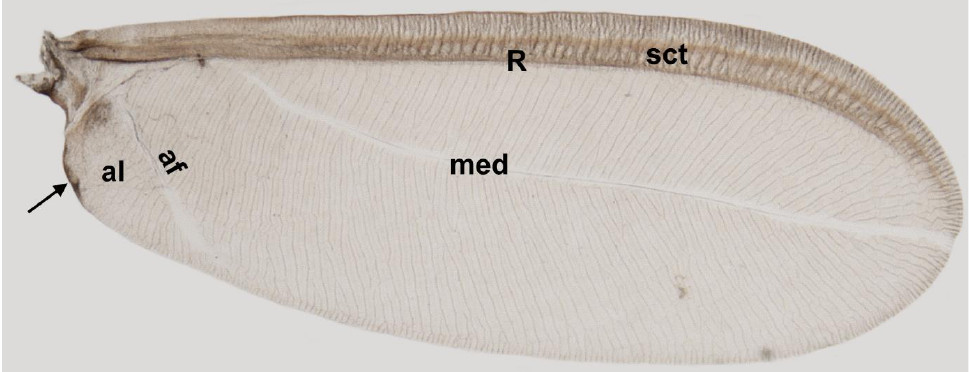
Figure 1. Forewing of Matsucoccus pini under LM. R—Radius, sct—subcostal thickening, med—median fold, al—anal lobe, af—anal fold; black arrow—narrow fold of anal lobe to hold